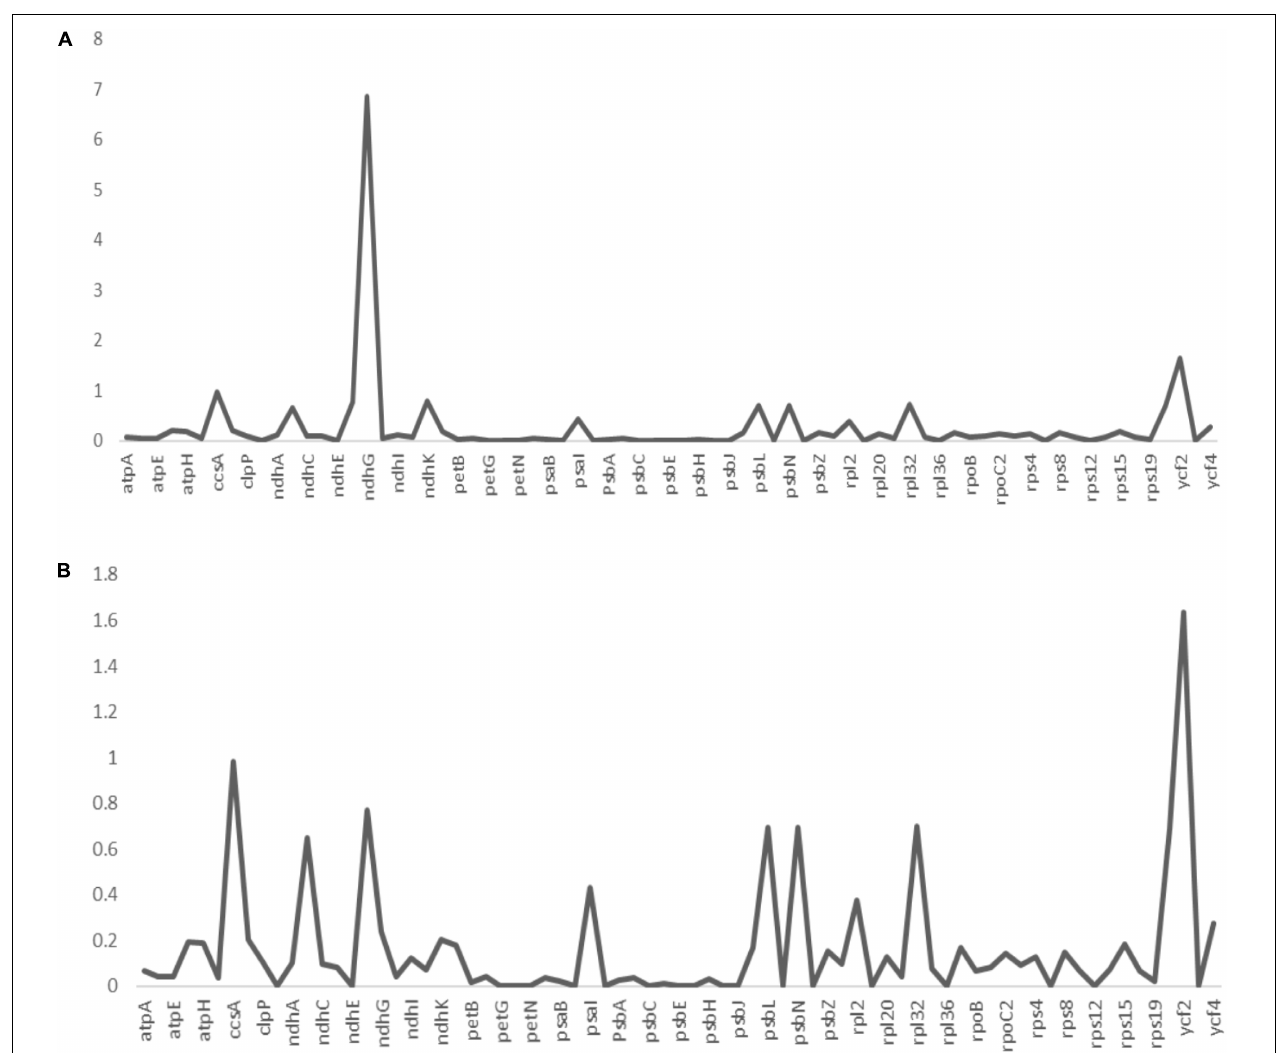
FIGURE 6 | The non-synonymous-to-synonymous substitution (Ka/Ks) ratios of 73 coding genes of (A) Acanthochlamys bracteata plastome relative to Xerophyta viscosa and (B) Acanthochlamys bracteata plastome relative to Xerophyta spekei . Note: Y- axis represents the Ka/Ks values (ratios) while the X- axis represents the protein-coding genes within the chloroplast